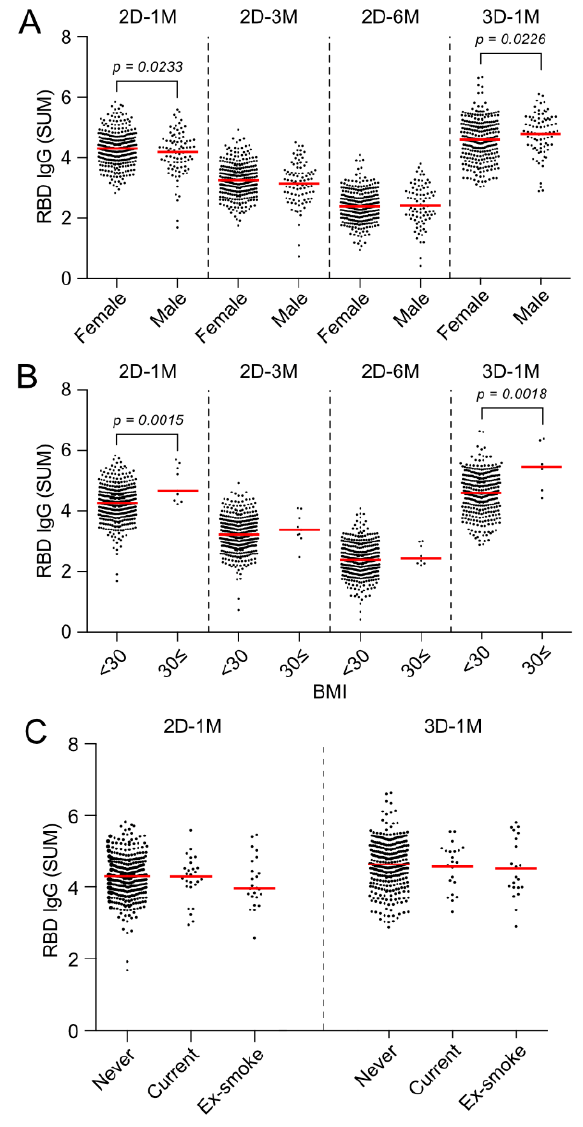
Figure 7. Effect of gender and BMI on anti-RBD IgG responses at 3 M and 6 M after the second dose and 1 M after the third dose of BNT162b2 vaccinations. ( A , B ) Effect of gender difference ( A ) and BMI ( B ) on anti-SARS-CoV-2 RBD IgG titers (SUM) at 3 M and 6 M after the second dose and 1 M after the third dose of BNT162b2. Horizontal lines represent the median. ( C ) Effect of smoking status on anti-SARS-CoV-2 RBD IgG titers (SUM) at 1 M after the second dose (2D-1M) and 1 M after the third dose (3D-1M) of BNT162b2. The horizontal lines in ( A – C ) are the median.